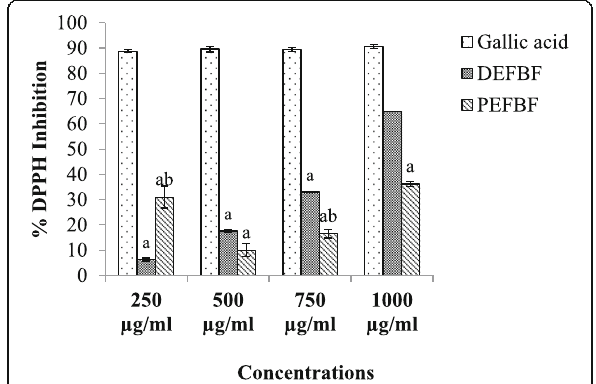
Fig. 2 DPPH scavenging activity of petroleum and diethyl ether fractions of B. ferruginea Benth leaves. a P<0.05: significant compared with Gallic acid; b P <0.05: significant compared with DEFBF. DEFBF IC 50 =426.54 μ g/